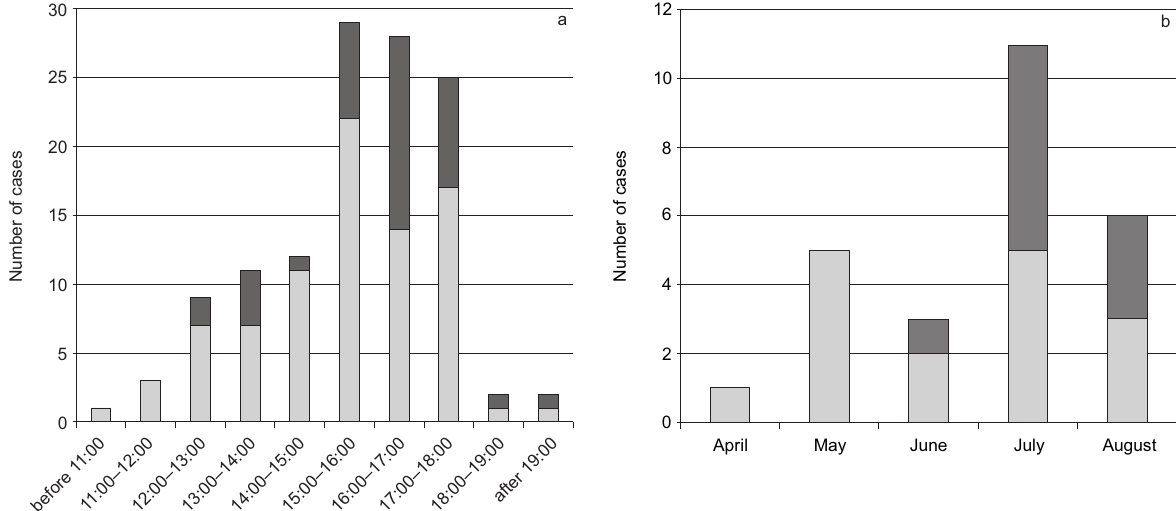
Fig. 1. Large hail in Poland observed in 2012 by a) – time (including all hail reports), and b) – month (including all hail days). Grey color indicate hailstones with diameter greater than 2 cm and less than 4 cm. Black color indicate hailstones with diam - eter greater or equal 4 cm (based on reports from